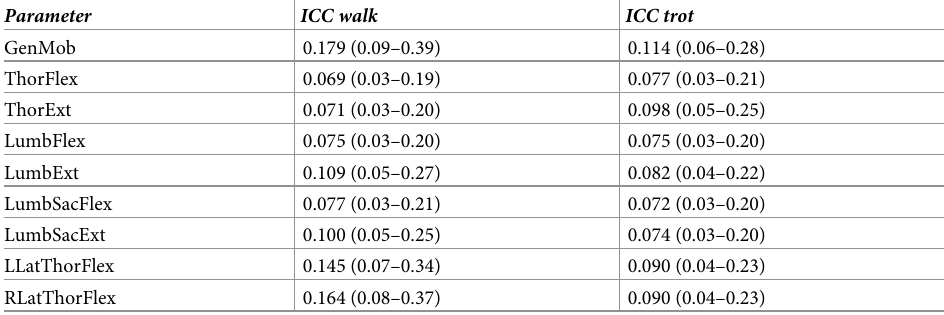
Table 2. Inter-rater reliability of scores and 95% confidence intervals of the 9 parameters at walk and trot expressed as ICC, n = 840 for both walk and trot.